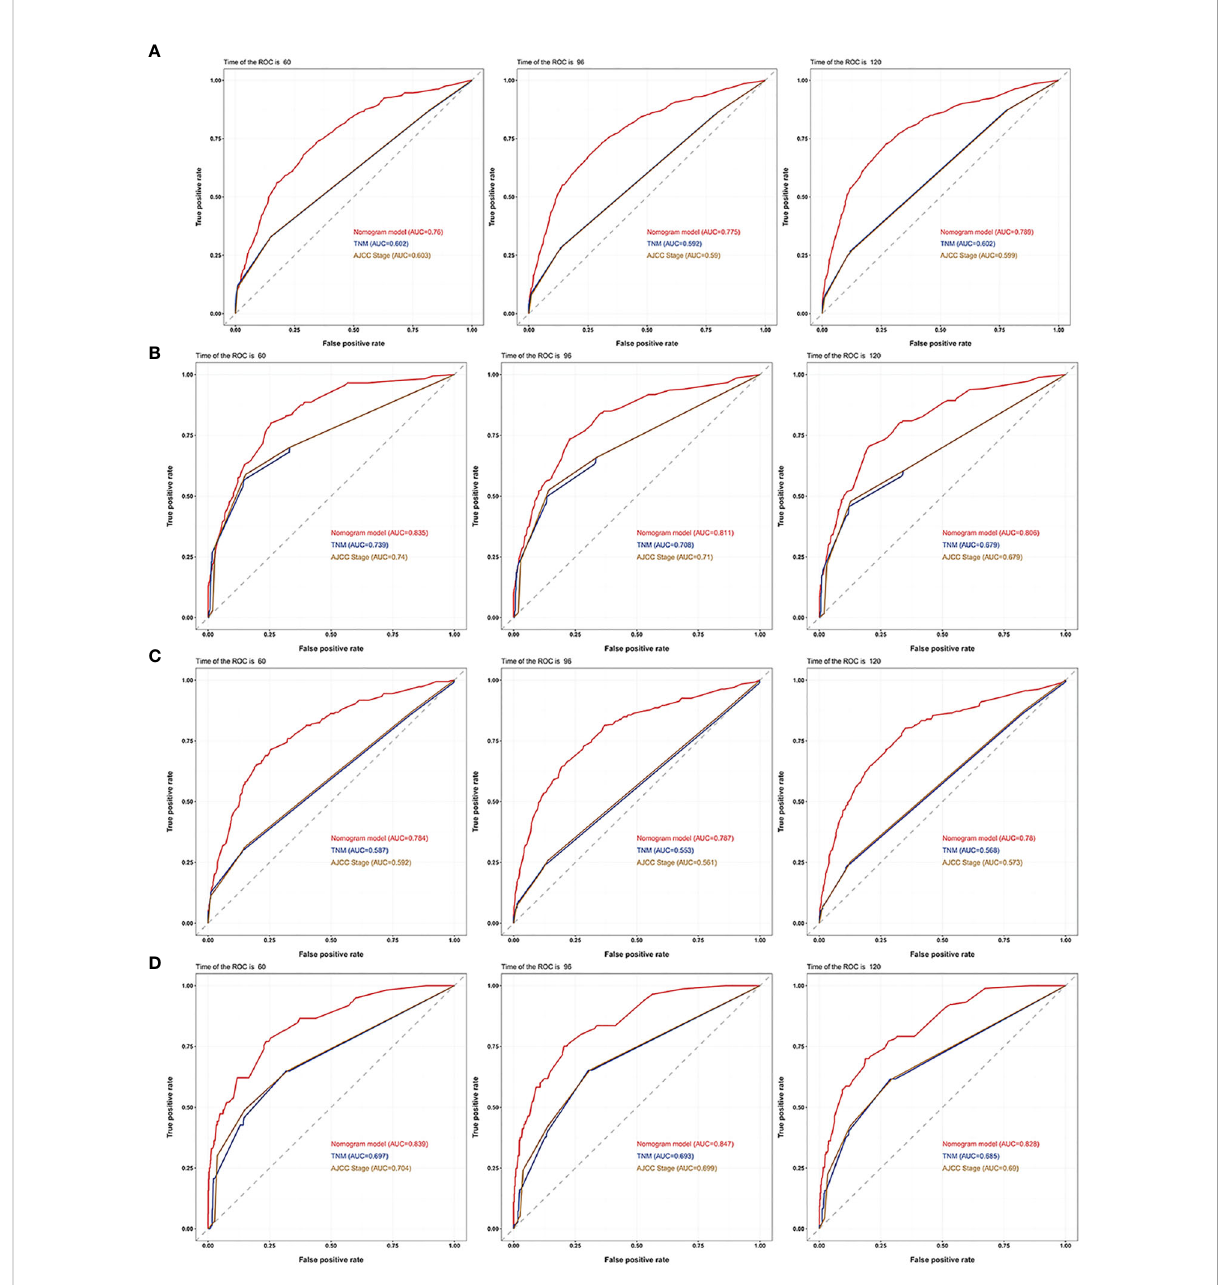
FIGURE 7 AUC curves of the nomogram, AJCC stage, and TNM stage for OS and CSS. AUC curves of the nomogram, AJCC stage, and TNM stage in prediction of prognosis at 5-, 8-, and 10-year point in the (A) training cohort for OS, (B) training cohort for CSS, (C) validation cohort for OS and (D) validation cohort for